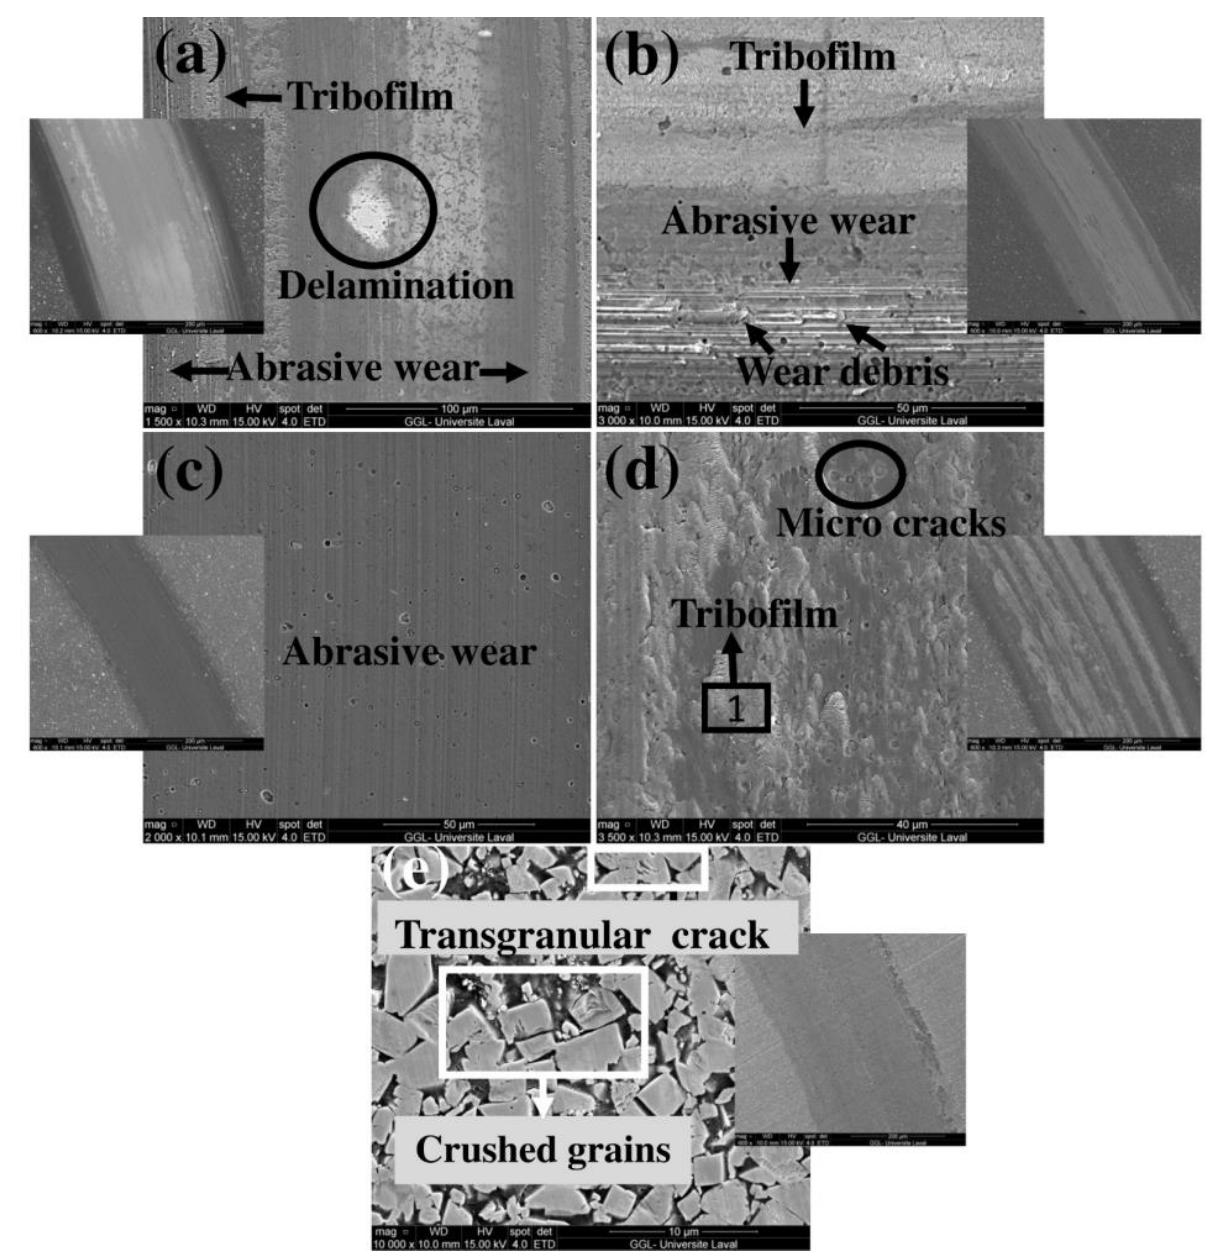
Figure 17. SEM micrographs of the wear track surface of different coatings at the sliding speed of 100 mm/s ( a ) CrN/CrCN/DLC, ( b ) CrN/AlTiN, ( c ) CrN/CrCN, ( d ) CrCN/TiSiCN, and ( e ) uncoated WC-Co substrate.